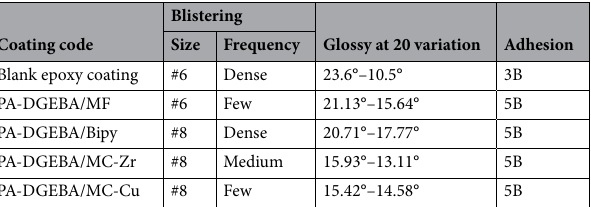
Table 10. Ultra violet test results of unmodified epoxy and the investigated modified cured epoxy coated panels after exposure to UV irradiance.